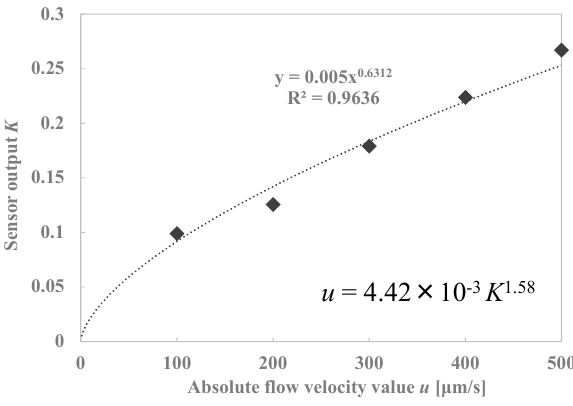
Figure 8. Results of the flow velocity measurement.